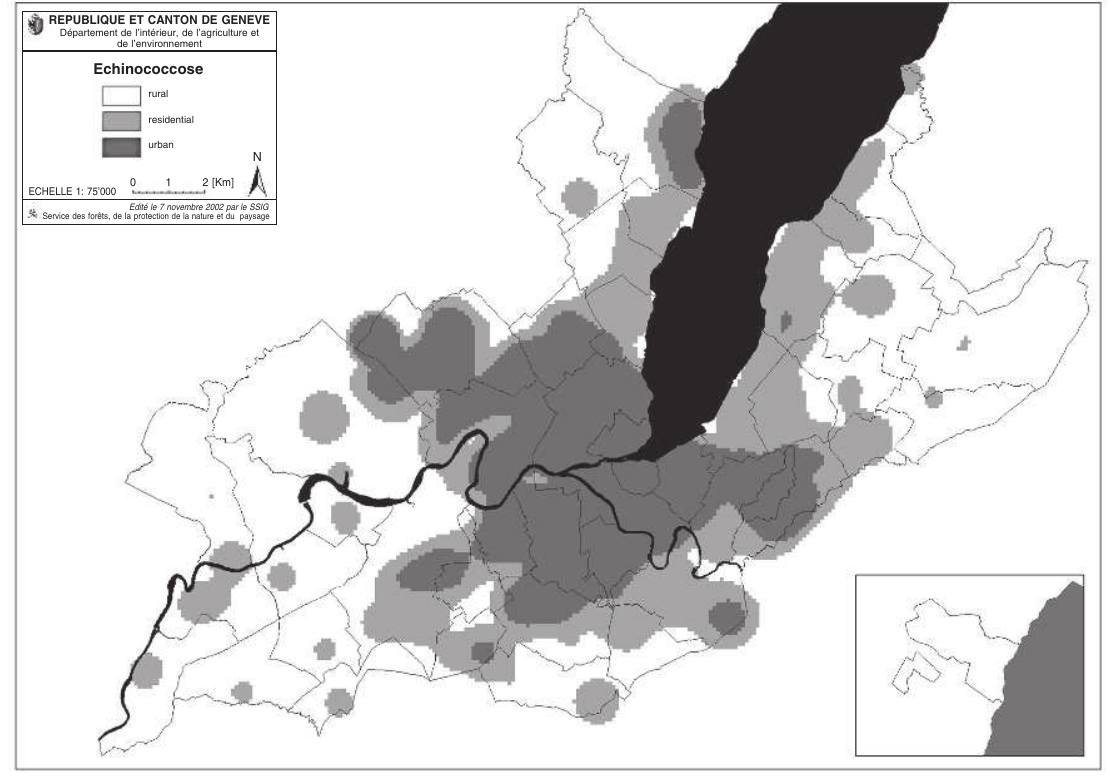
2. – Representation of the three considered areas: white = rural; light grey = residential; dark grey = urban.